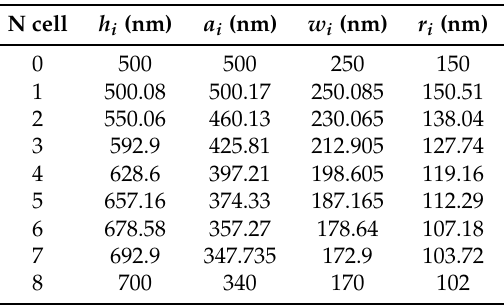
Table 2. Tapered cavity parameters.